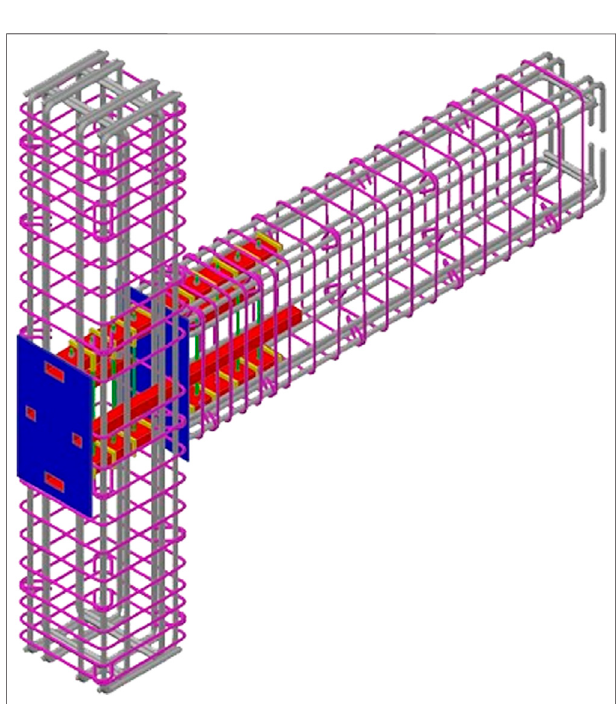
FIGURE 3 | Reinforcement and connection detail of precast test